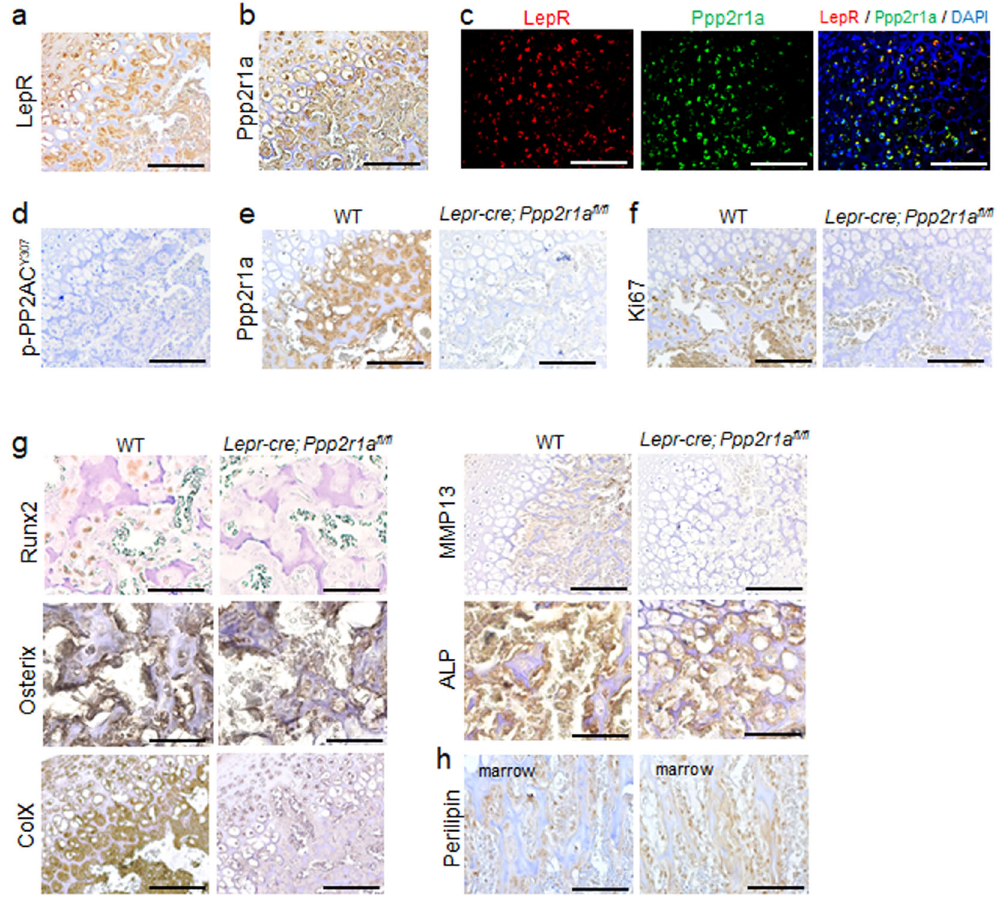
Fig. 4 Deletion of PP2A in LepR + MSCs inhibited proliferation and hypertrophic differentiation of SOC in early postnatal stage. Sections of P15 distal femur from Lepr-cre; Ppp2r1a fl / fl mice were subjected to immunostaining. a – d Immunohistochemistry (IHC) and immuno fl uorescence reveal LepR + MSCs express Ppp2r1a and unphosphorylated (Y307) PP2AC in SOC. (a) LepR IHC. b Ppp2r1a IHC. c Double immuno fl uorescence of LepR and Ppp2r1a. d Unphosphorylated (Y307) PP2AC IHC. e IHC reveals successful deletion of Ppp2r1a in LepR + MSCs in SOC. IHC reveals that deletion of Ppp2r1a in LepR + MSCs leads to decreased expression of Ki67 ( f ) and hypertrophic markers, such as Runx2, Osterix, collagen X, MMP13 and alkaline phosphatase ( g ), and increased expression of Perilipin ( h ) in SOC at P15. HZ = Hypertrophic zone; POC = Primary ossi fi cation center; ColX = collagen X; ALP = alkaline phosphatase. Scale bar, 100 μ